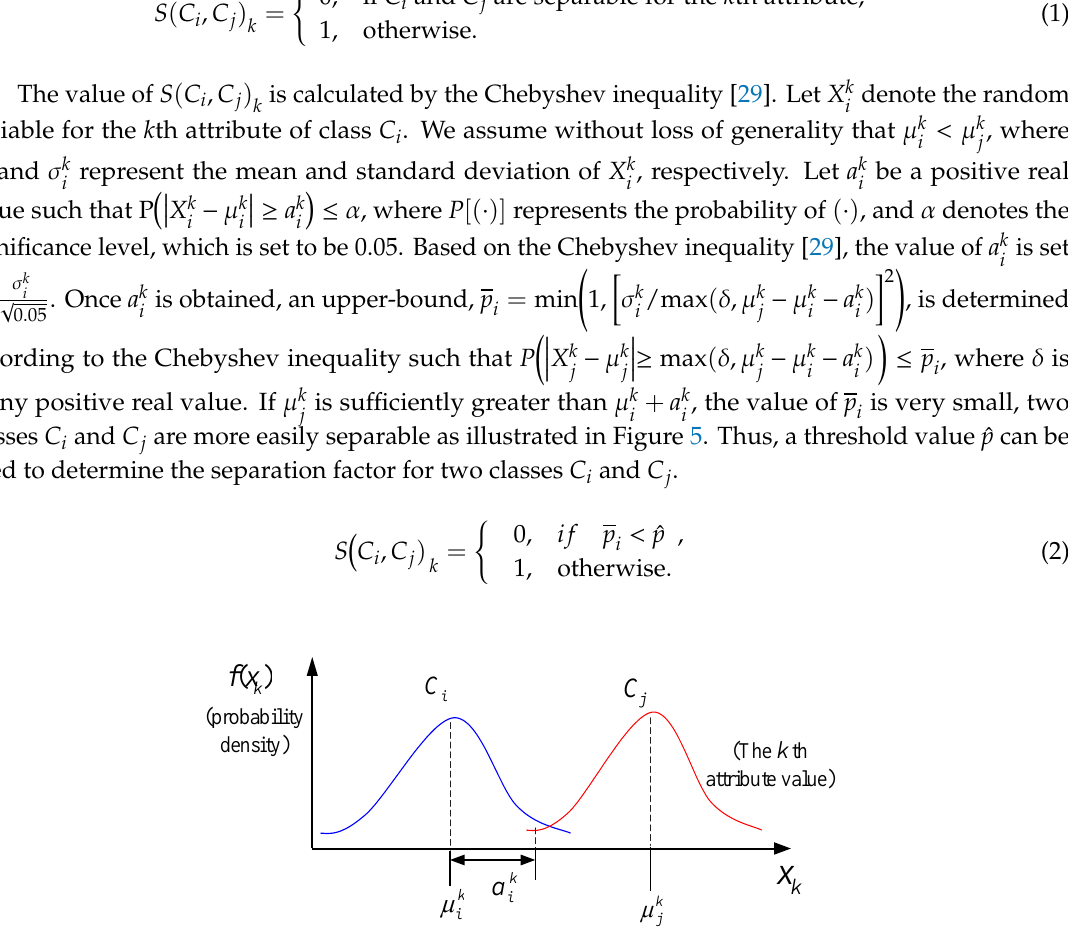
Figure 5. Separation of two classes based on